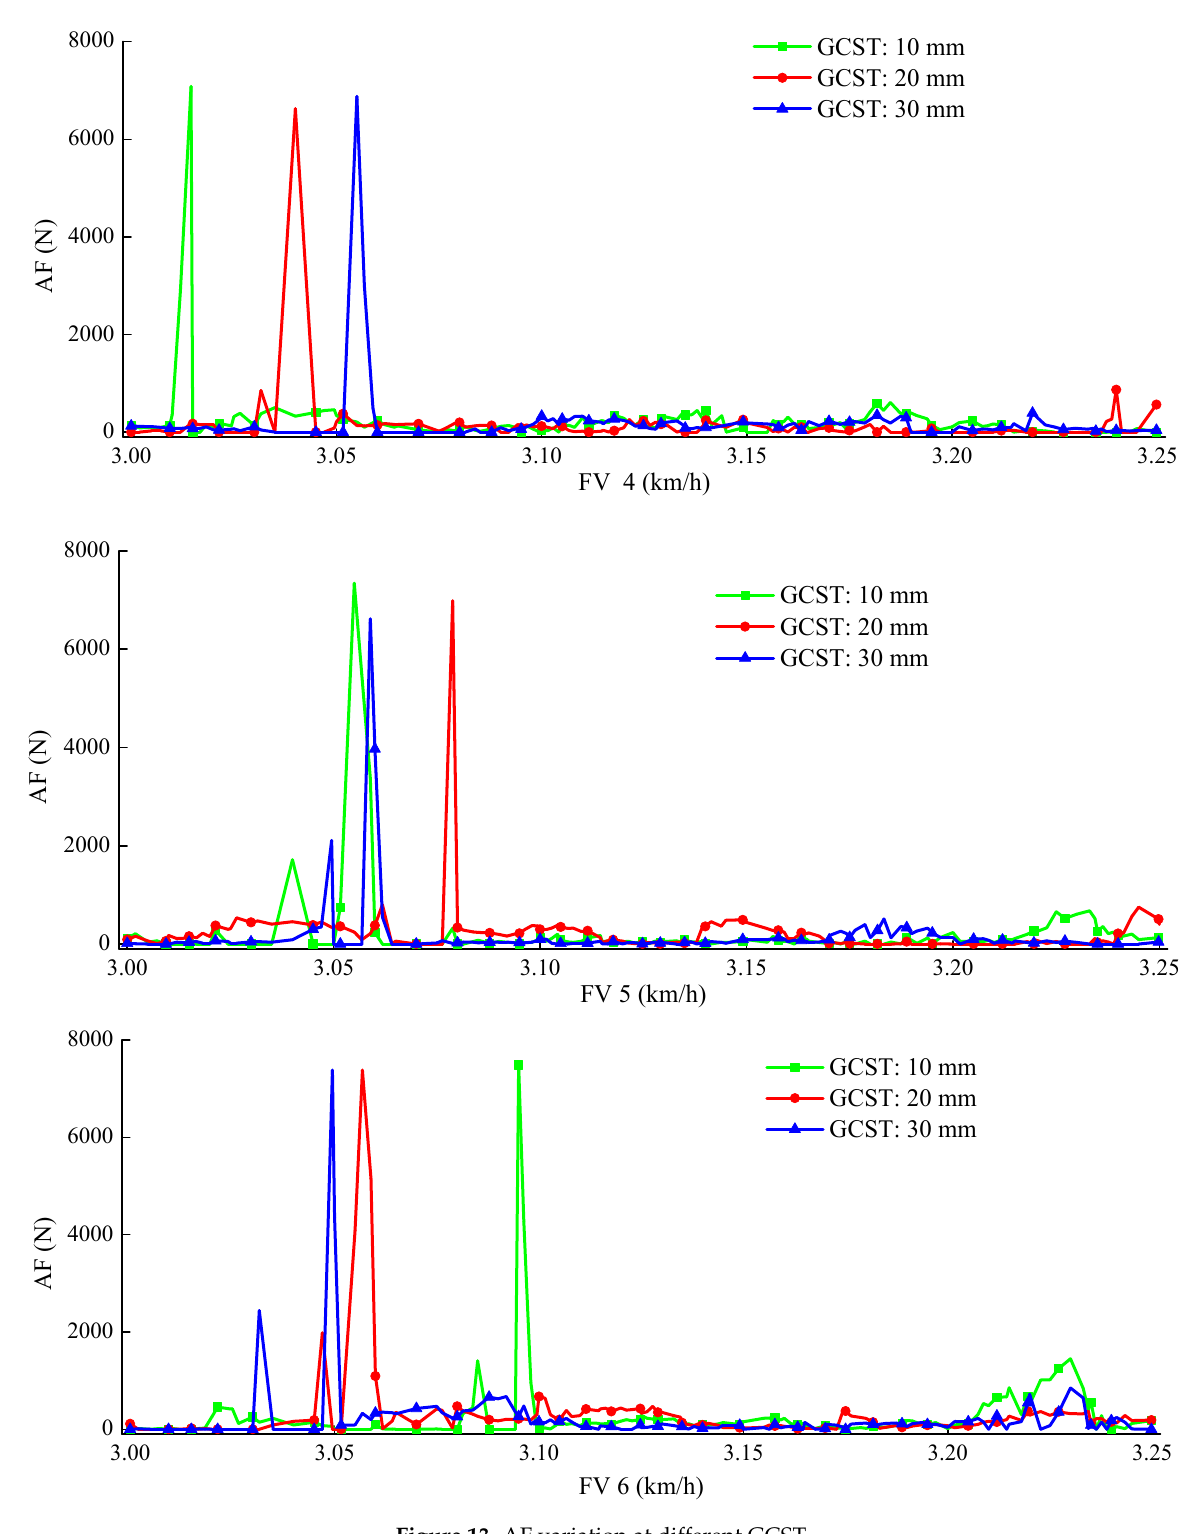
Figure 13. AF variation at different GCST.